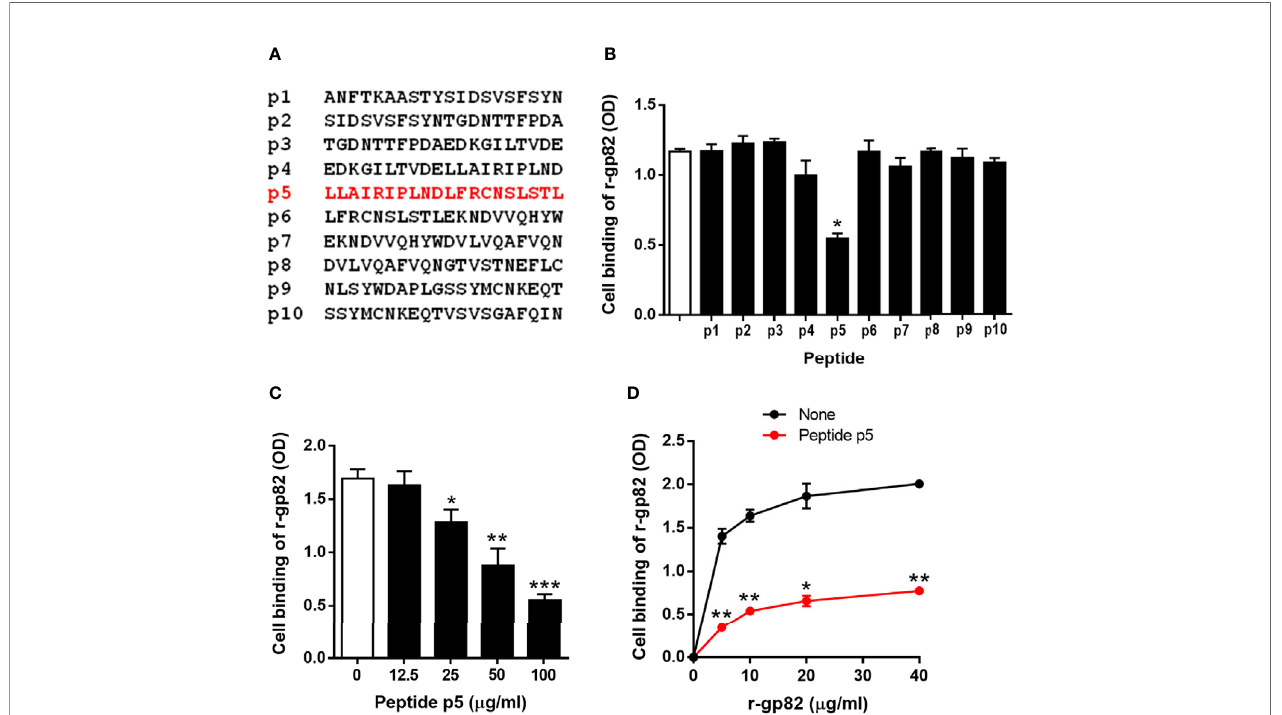
FIGURE 2 | Inhibition of gp82 binding to cells by peptide p5. (A) Sequences of peptides spanning the LAMP2 domain identi fi ed as the site of interaction with gp82. (B) HeLa cells were incubated with r-gp82, in absence or in the presence of the indicated peptide. Binding was measured by ELISA. Representative results of one of three assays are shown. Values are the means ± SD of triplicates. Inhibition by peptide p5 was signi fi cant (* P < 0.0001). (C) HeLa cells were incubated with r-gp82, at 40 m g/ml, in absence or in the presence of peptide p5 at the indicated concentrations. Values are the means ± SD of three experiments performed in triplicate. Inhibition by peptide p5 at different concentrations was signi fi cant (* P < 0.01, ** P < 0.005, *** P < 0.0001). (D) HeLa cells were incubated with r-gp82, at the indicated concentrations, in absence or in the presence of peptide p5 at 100 µg/ml. Values are the means ± SD of triplicates from a representative assay. Binding of r-gp82 to cells was signi fi cantly inhibited in the presence of peptide p5 (* P < 0.0005, ** P <